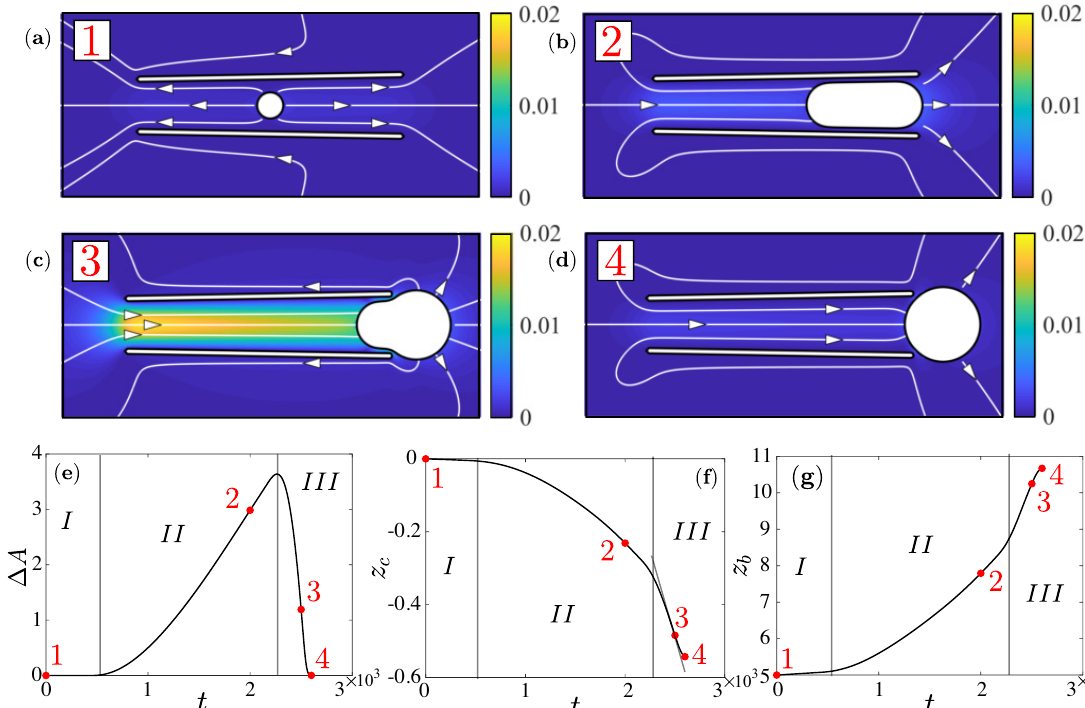
Figure 2. A bubble cycle for Ca = 0.01 and θ = 1 ◦ . ( a – d ) velocity magnitude and streamlines in the lab frame at four times from the bubble nucleation until when the bubble exits the cone; ( e ) Excess surface area versus time; ( f ) Cone and ( g ) bubble displacements versus time. The vertical lines separate three phases.